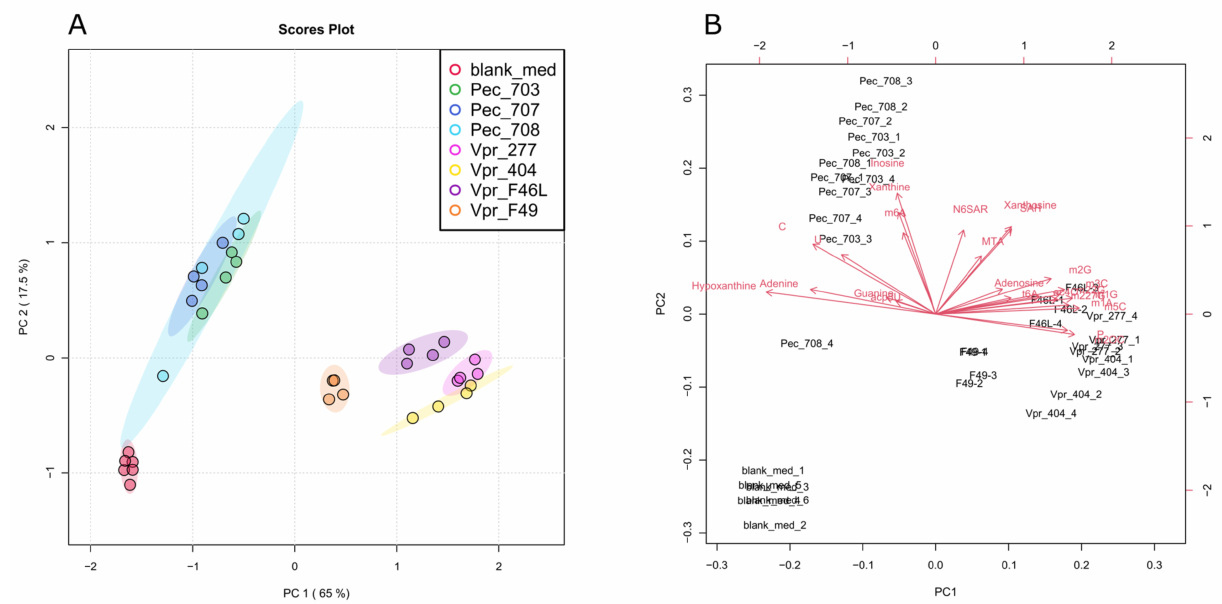
Figure 1. ( A ) Discrimination of investigated cell lines’ exometabolite profile by principal compo- nent analysis (PCA) indicating similarities and differences between samples and groups. Shaded area = confidence ellipses show 95% confidence regions. Percentage of variance explained by indi- vidual component is indicated, with PC 1 reaching 65 % variance and PC2 reaching 17.5% variance. Samples represented by dots. N = 4 for PEC and VPR, N = 6 for blank. ( B ) PCA Biplot displays how the individual metabolites contribute to the discrimination of the